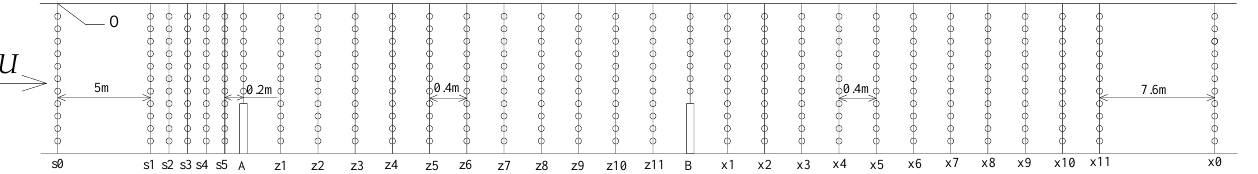
Figure 2. Distribution of measured cross-sections and points.